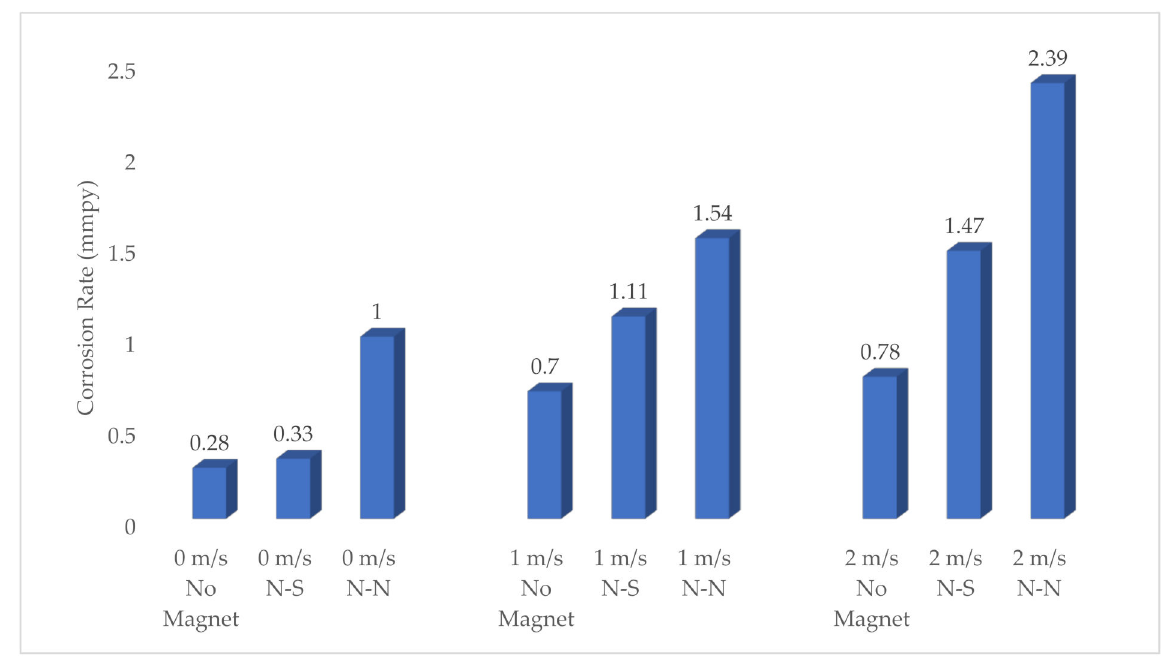
Figure 8. Corrosion rate of API 5L X65 samples at different magnetic field and different flow